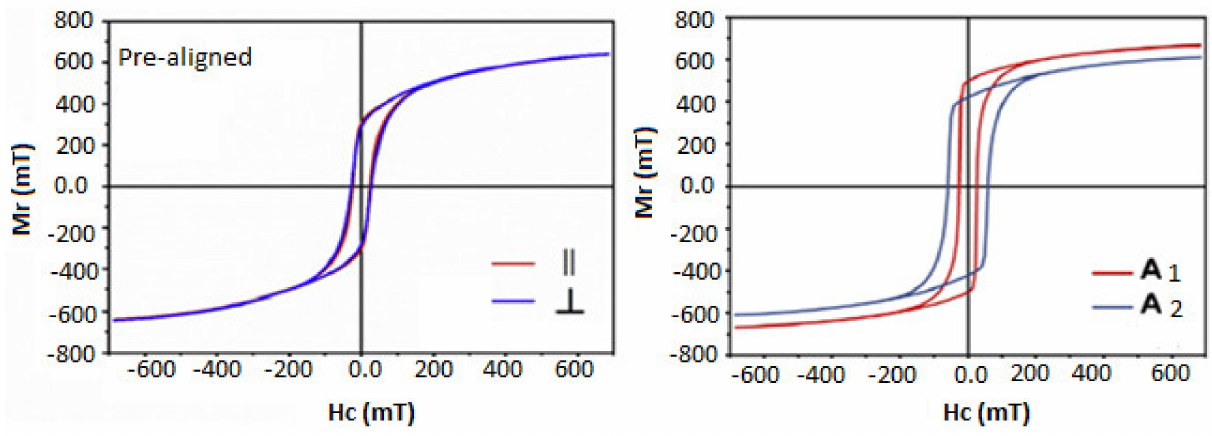
Figure 1. M (cid:107) (H) curves for the in situ aligned samples without binder during the SPS process, adopted from Ref.